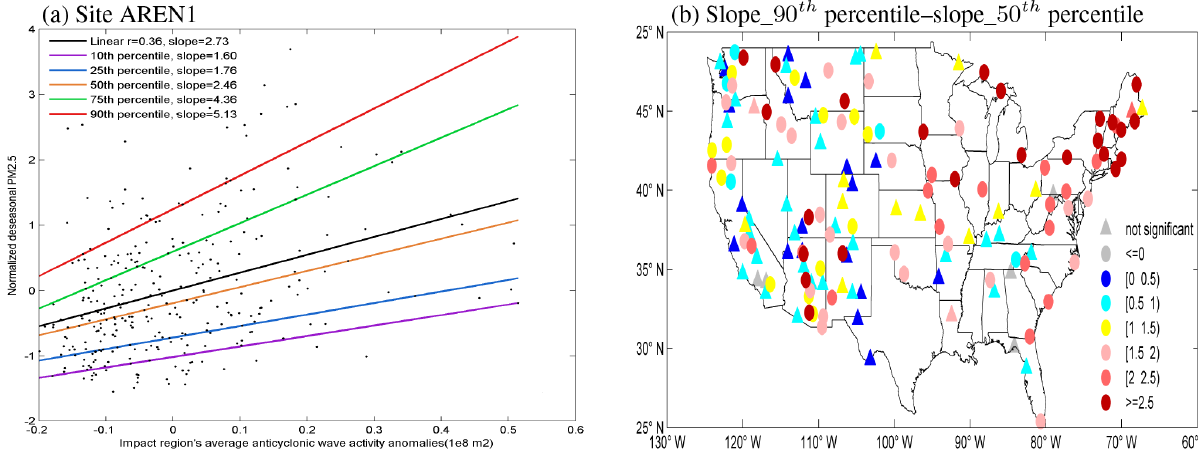
Figure 7. (a) Scatterplot for site AREN1 JJA deseasonalized PM 2 . 5 and the impact region’s average AWA with linear and quantile regression results. (b) The subtraction of the 50th-percentile quantile regression slope from the 90th-percentile quantile regression slope between PM 2 . 5 and the impact region’s average AWA across all 150 sites in the US (at the 5% significance level).